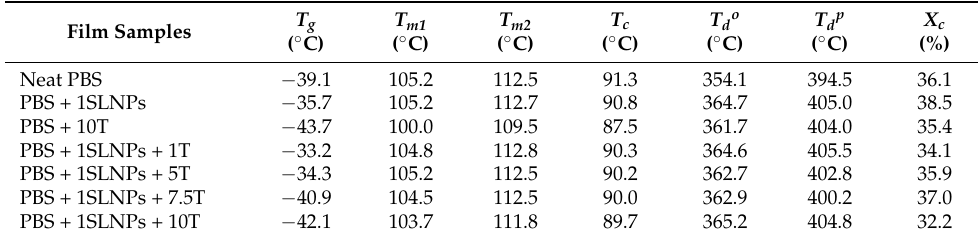
Table 2. Thermal properties of neat PBS and PBS